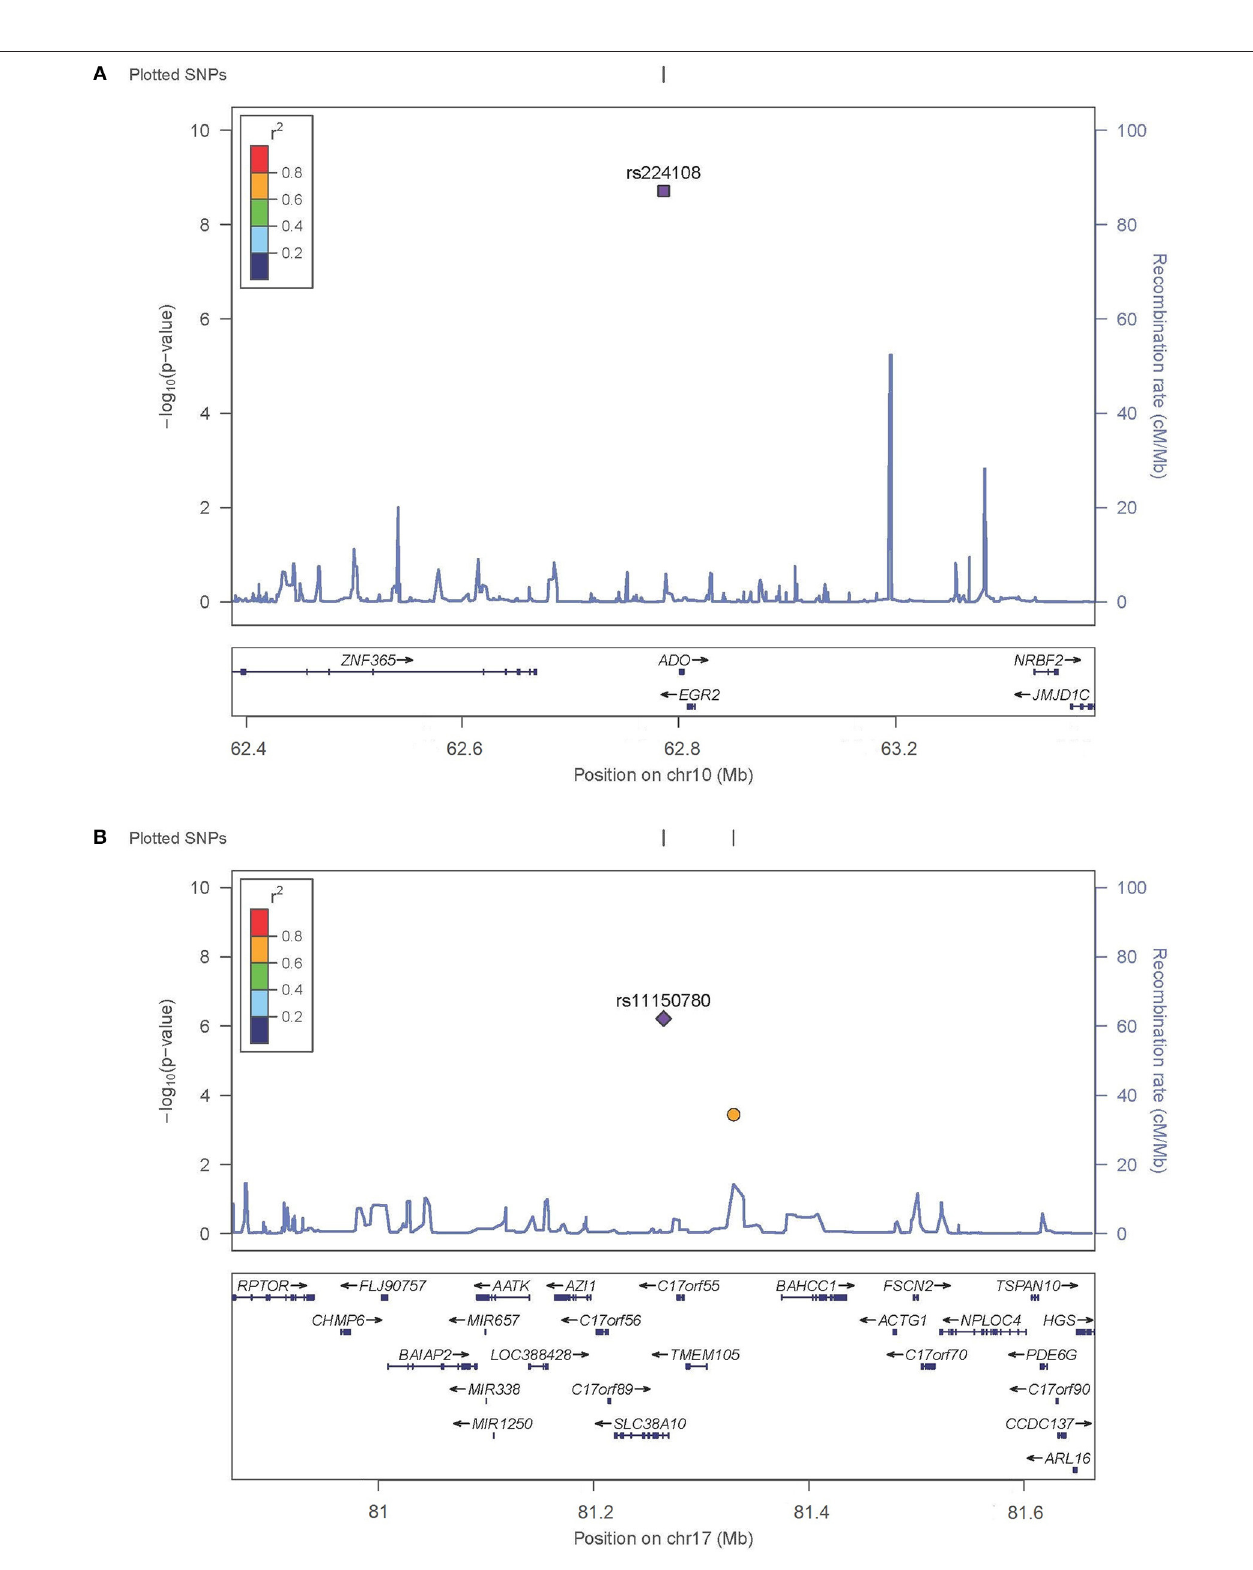
FIGURE 2 | Regional plots for associated SNPs. The P -values of SNPs shown as –log 10 values (y axis) were presented against their chromosomal positions (x axis). Estimated recombination rates were plotted in light blue. SNPs showed strong signal were labeled out. (A) Regional plots for rs224108 on 10q21.2. (B) Regional plots for rs1150789 on